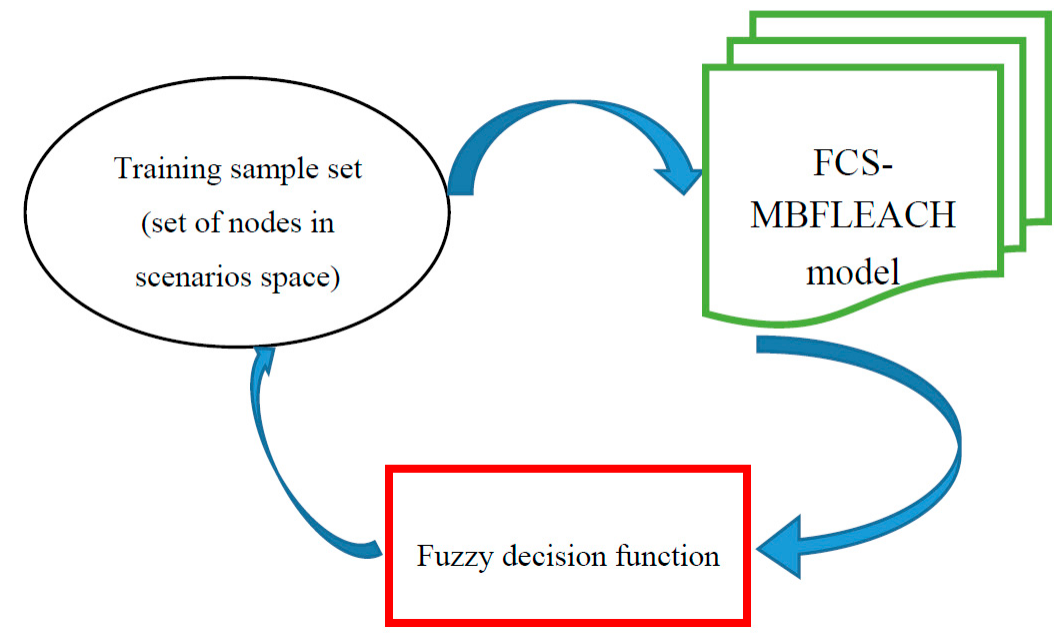
Figure 5. The learning phase.